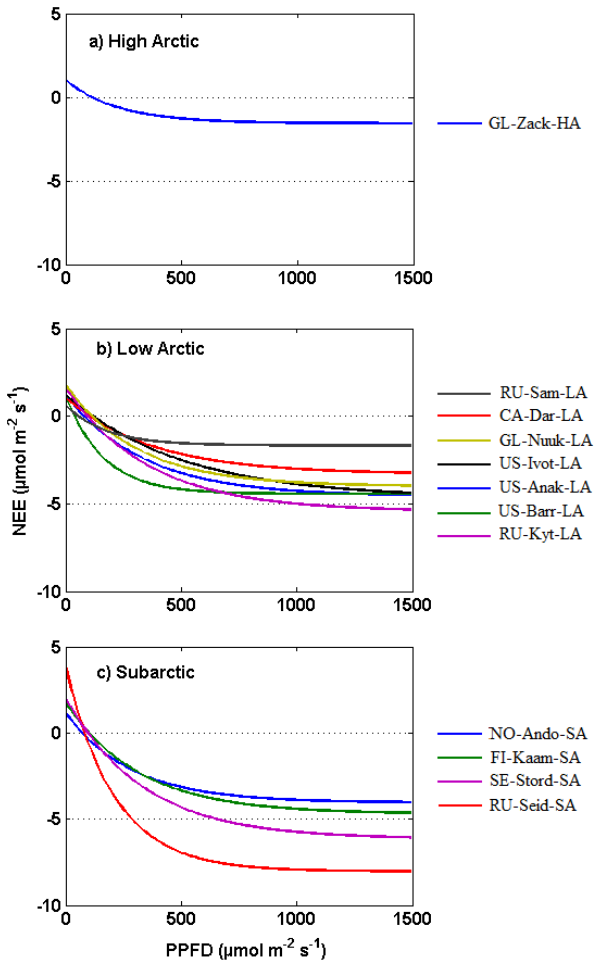
Figure 5. Variability in LRC parameters among Arctic tundra sites. (a) Flux at light saturation ( F csat ); (b) dark respiration ( R d ); (c) ini- tial light use efficiency ( α) ; (d) potential photosynthesis at light sat- uration ( P sat ); (e) flux when PPFD = 1000µmolm − 2 s − 1 ( F c 1000 ) ; and (f) light compensation point (LCP). Illustrated according to mean July temperature in different tundra types.